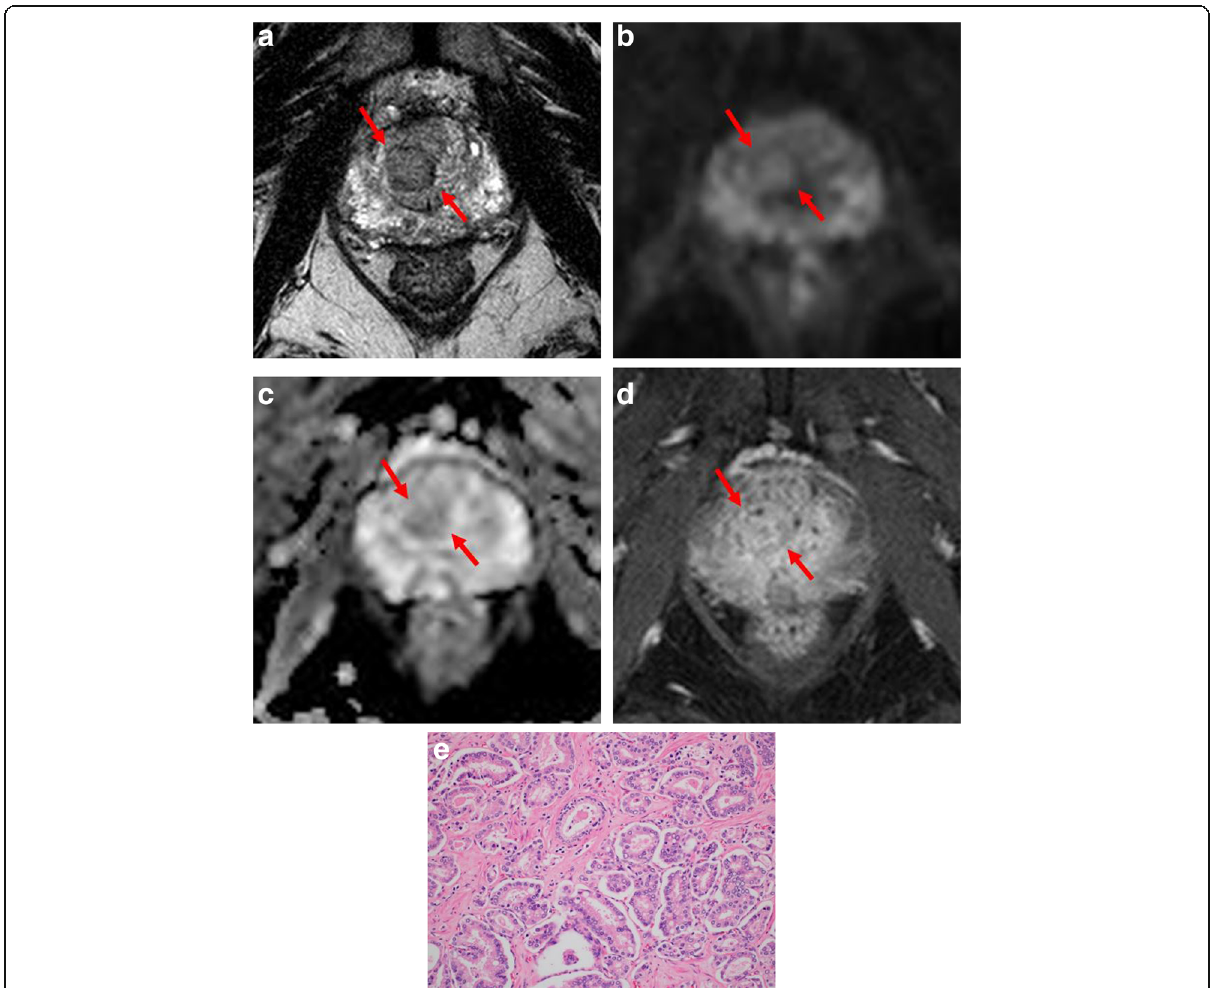
Fig. 5 Multiparametric magnetic resonance image of a 69-year-old patient who underwent radical prostatectomy (serum prostate-specific antigen 8.3 ng/ml, apparent diffusion coefficient [ADC] 1.140). An axial T2-weighted image (T2WI) ( a ) and dynamic contrast-enhanced image ( b ) indicate an approximately 1.3 cm, heterogeneous, obscured, marginated nodule with mild enhancement in the right transition zone (arrows), resulting in a T2WI score of 3. Diffusion-weighted imaging (DWI) ( b = 1000) ( c ) demonstrated subtle iso-signal intensity at the corresponding nodule with low signal intensity on an ADC map ( d ), resulting in a DWI score of 3. This lesion was categorized as 3 according to PI-RADS v2.1 but as 3A according to PI-RADS v2.1-B. The patient underwent radical prostatectomy, which confirmed transition-zone cancer with a Gleason score of 7 (4 + 3). The procedure revealed crowded irregular glands with at least a wisp of stroma between each gland ( e ). This was a false-negative case first categorized with a T2 score of 3 and DWI score of 3. The final category was determined to be 3 based on v2.1 and 3A based on v2.1-B, which is pathologically confirmed malignancy